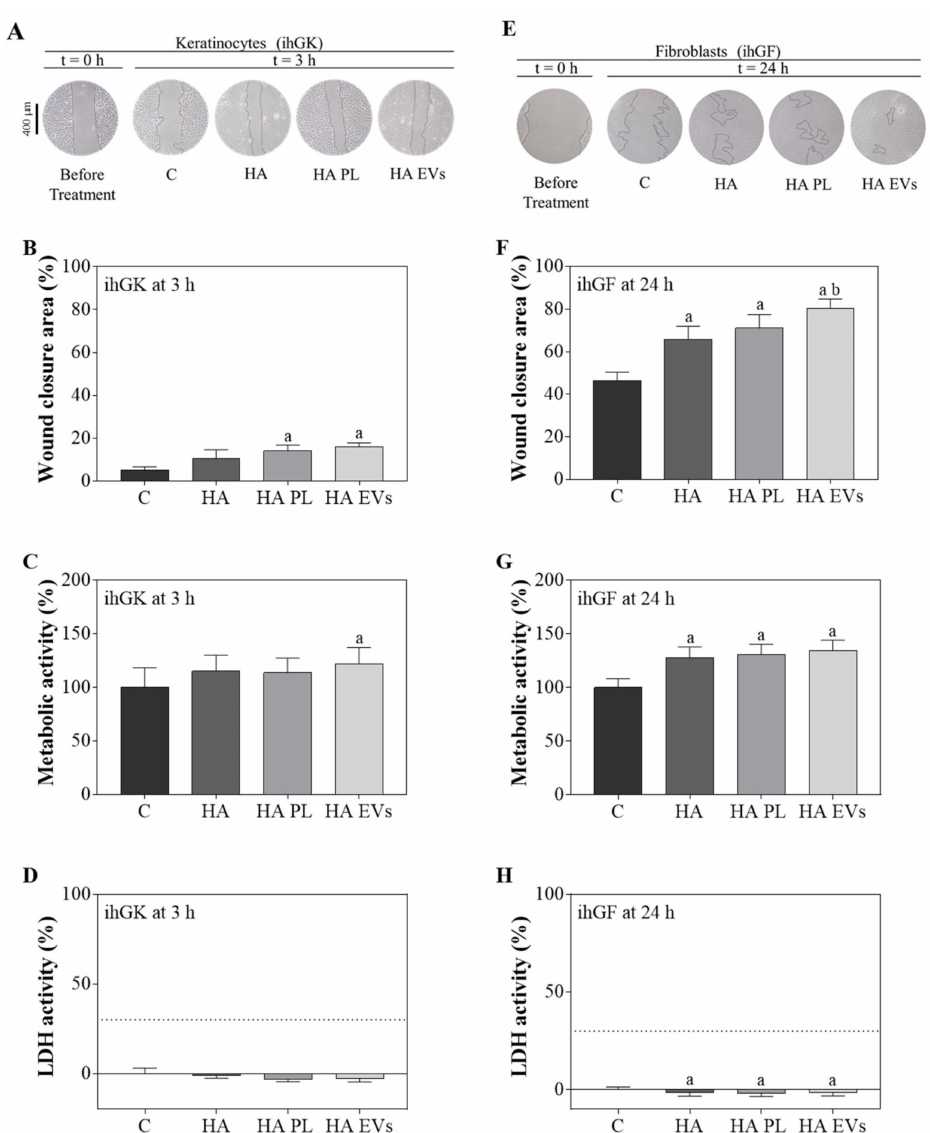
Figure 5. Effects of HA and its combination with PL and EV after the wound-healing assay. ( A ) Images of ihGK cell morphology at t = 0 h and t = 3 h of treatment; images were taken at a × 100 augments. ( B ) Wound closure area after 3 h of treatment of ihGK. ( C ) Metabolic activity of ihGK after 3 h of treatment; data of the control group was set as 100%. ( D ) LDH activity measured in ihGK culture media after 3 h of treatment; control group was set as 0% of toxicity and culture media from cells treated with 1% Triton X-100 was set at 100%. A dashed line is shown at 30%, which is the maximum value accepted for cytotoxicity of medical devices according to ISO-10993:5. ( E ) Images of ihGF cell morphology at t = 0 h and t = 24 h of treatment, images were taken at × 100 augments. ( F ) Wound closure area after 24 h of treatment of ihGF. ( G ) Metabolic activity of ihGF after 24 h of treatment, data of the control group was set as 100%. ( H ) LDH activity measured in ihGF culture media after 24 h of treatment; control group was set as 0% of toxicity and culture media from cells treated with 1% Triton X-100 was set at 100%. A dashed line is shown at 30%, which is the maximum value accepted for cytotoxicity of medical devices according to ISO-10993:5. Values represent the mean ± SEM. For ihGK, 9 independent experiments, with at least duplicate wells per group ( n = 9), were performed, while for ihGF, 7 independent experiments, with at least duplicate wells per group ( n = 7), were performed. Results were statistically compared by paired t -tests. Statistically significant differences were considered for p < 0.05 and represented with “a” compared to the control and “b” compared to